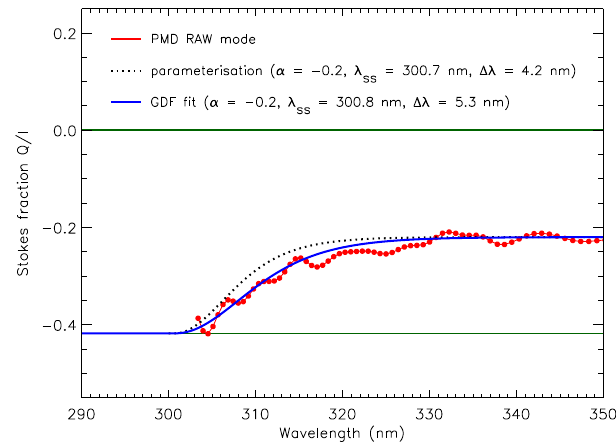
Figure 11. Polarisation Stokes fraction Q/I for scene 2 defined Fig. 11. Polarisation Stokes fraction Q/I for scene “2” defined in Fig. 2 (red points) and in Fig. 2 (red points) and GDF function based on parameterisation GDF function based on parameterisation (blue curve). Fit parameters are given in the plot. (blue curve). Fit parameters are given in the plot. The agreement is The agreement is good.